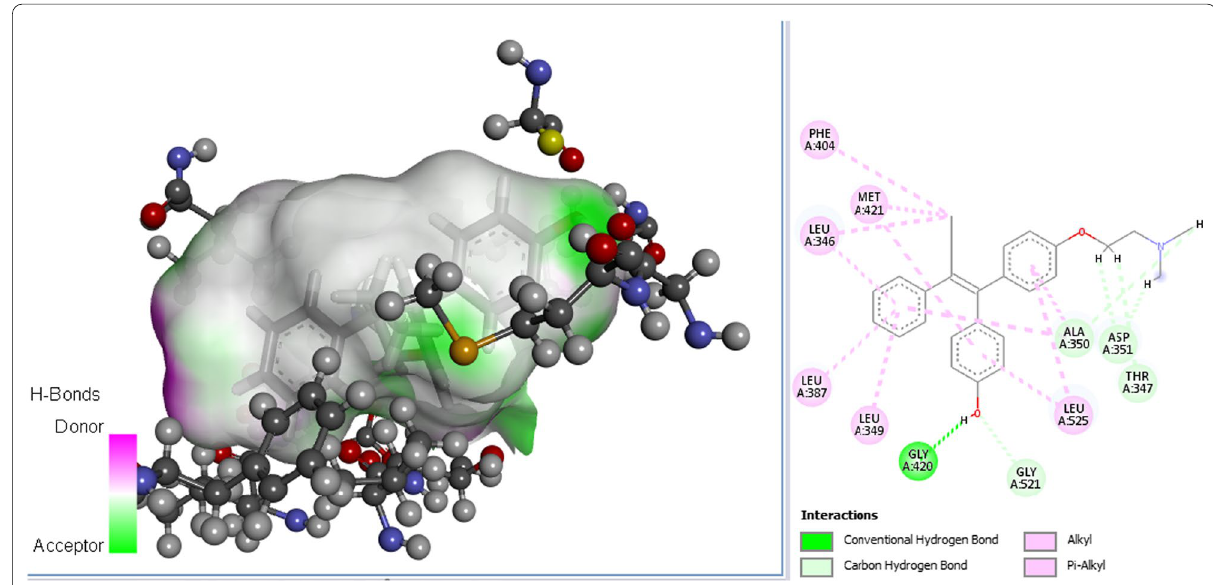
Fig. 17 3D and 2D interaction modes of redocked Tamoxifen with the active site of the ER +